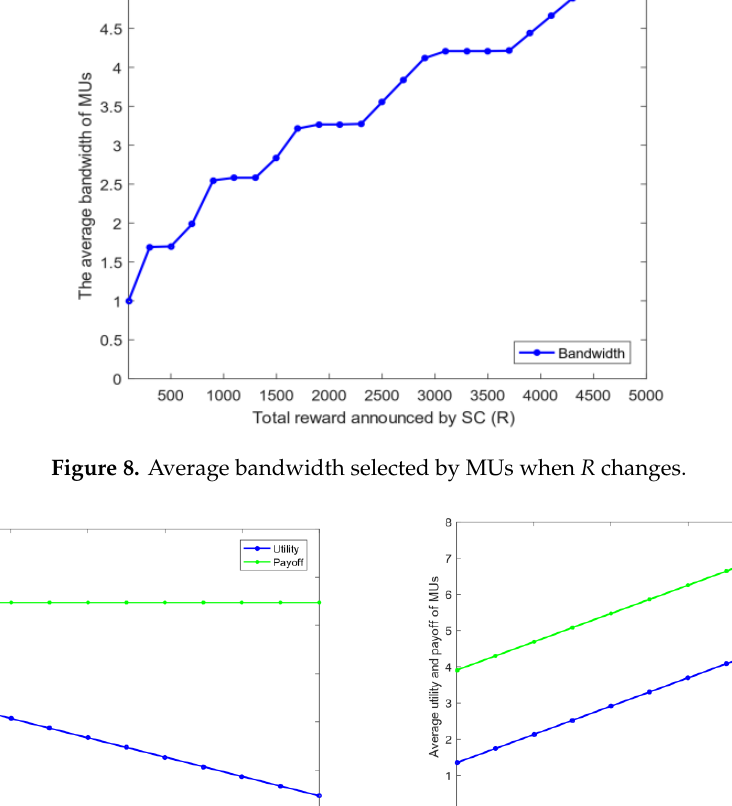
Figure 8. Average bandwidth selected by MUs when R changes.